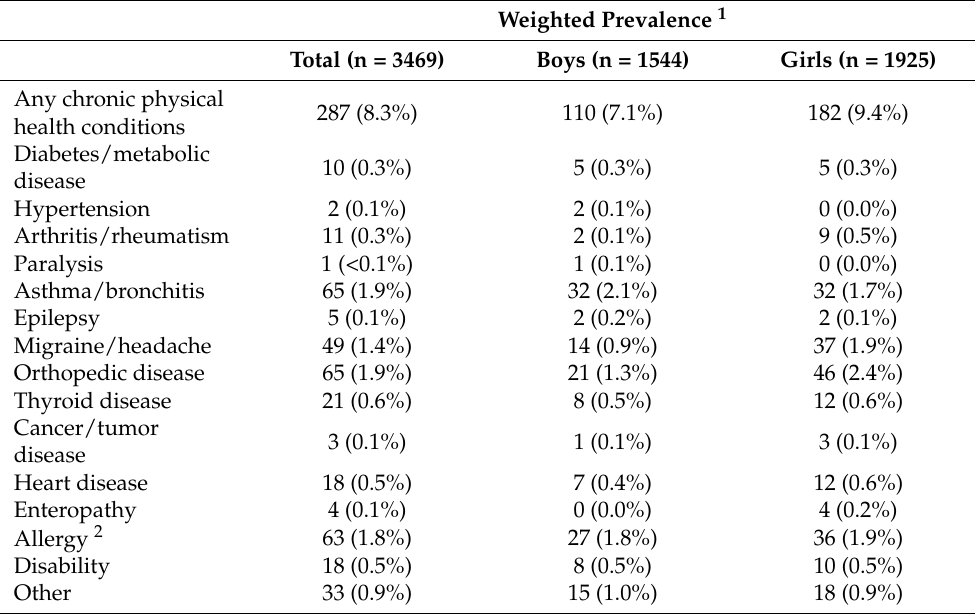
Table 1. Prevalence of chronic physical health conditions in the total sample and by gender.